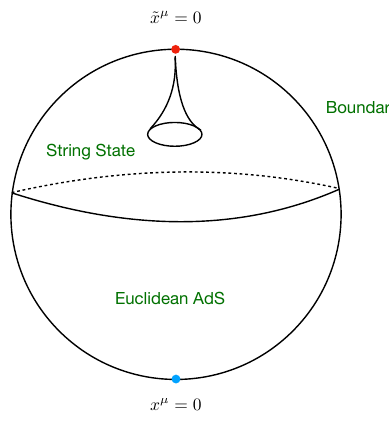
Figure 1 . Euclidean AdS 5 as a unit ball: the boundary is S 4 and our half-BPS state is coming from the north pole x = ∞ ( ˜ x = 0